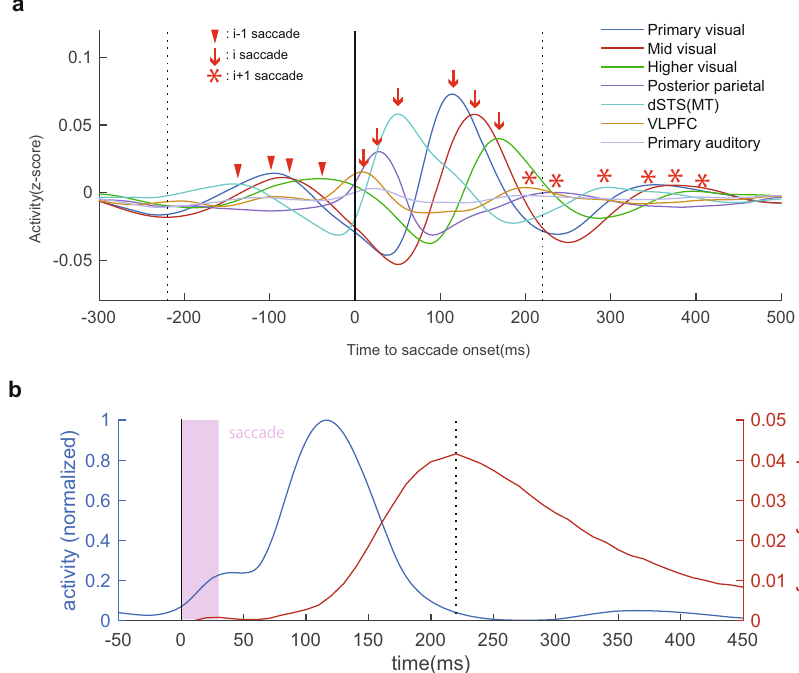
Fig. 8 Recurrent dynamics of neural activity and saccade behavior. a Relay of information across cortical areas around a saccade. Red arrows, representing the local peak activity of each electrode, show three peaks that were derived from the i − 1, i , and i + 1 saccade, respectively. Local maxima of high-gamma activity were successively relayed across cortical areas during natural vision, and the cortex did not return to baseline levels of activity as the next saccade occurred every 220 ms. b Inter-saccade interval and temporal dynamics of whole-brain activity. Whole-brain activity almost returned to background levels at 200 – 250 ms after the saccade, and this timing corresponds to when the next saccade emerged most